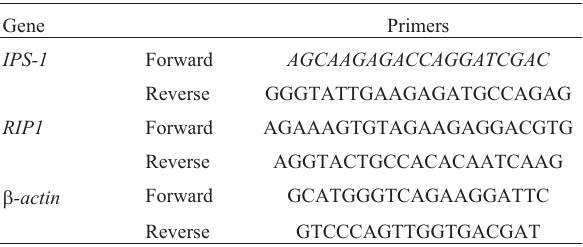
Table 1 - Primer sequences used in real-time